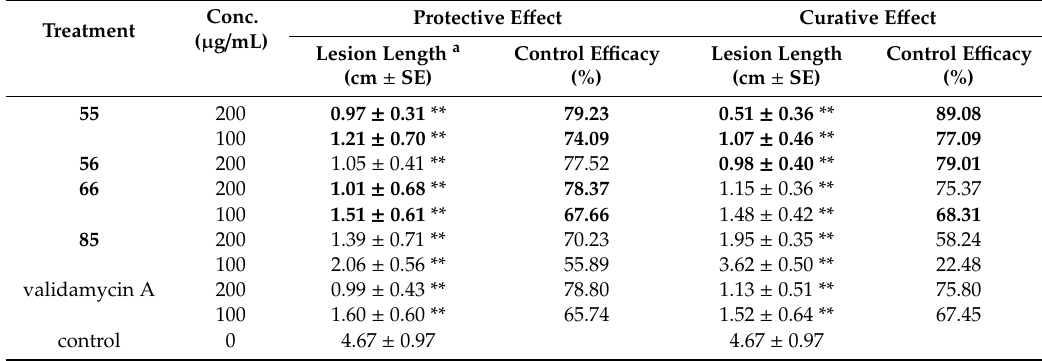
Table 6. In vivo protective and curative e ff ects against R. solani using greenhouse experiment. Treatment